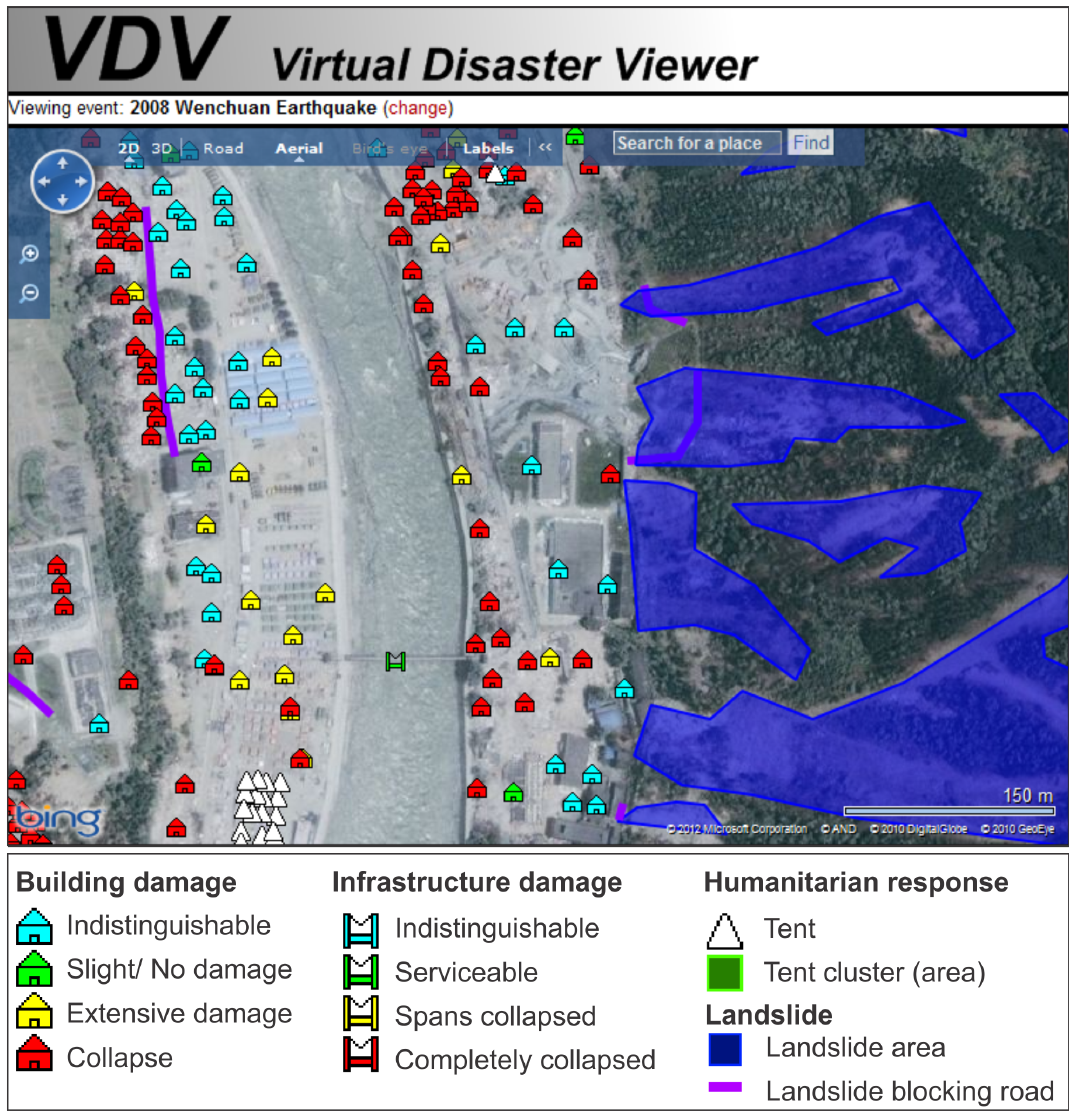
Fig. 7. ImageCat’s Virtual Disaster Viewer, showing damage mapped following the 2008 Wenchuan (China) earthquake. Damage assessment was more difficult than in Haiti, given (i) the relatively low image detail (QuickBird with 2.4m multispectral resolution), (ii) low image contrast and haze, and (iii) the larger number of damage types. For example, accurate detection of serviceable bridges or roads blocked by landslides requires additional distinct image analysis